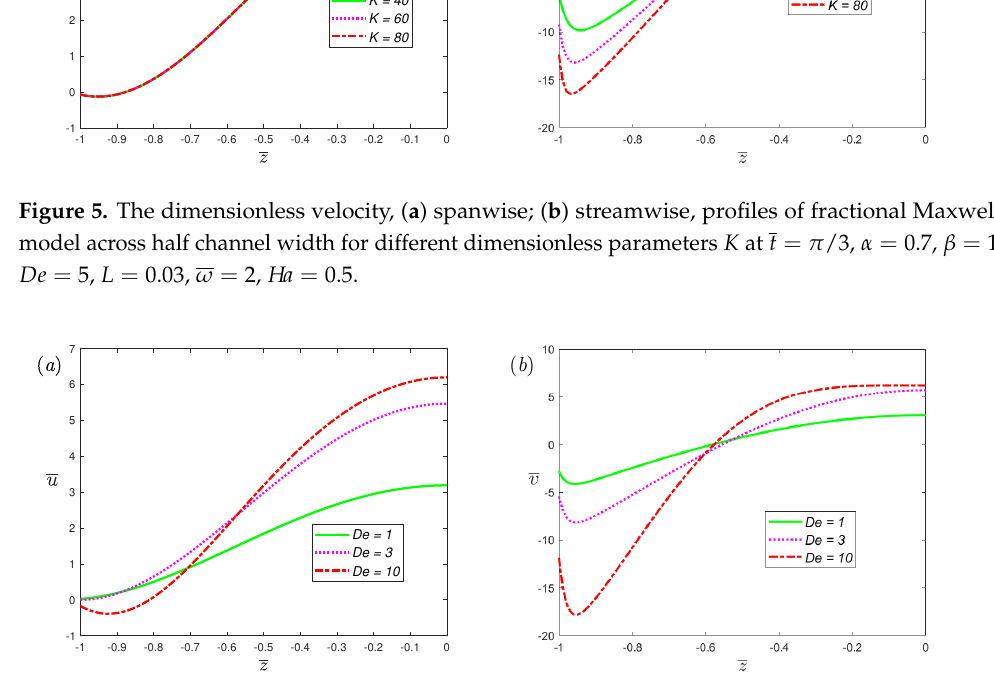
Figure 6. The dimensionless velocity, ( a ) spanwise; ( b ) streamwise, profiles of fractional Maxwell model across half channel width for different dimensionless parameters De at t = π /3, α = 0.7, β = 1, K = 50, L = 0.03, ω = 2, Ha =